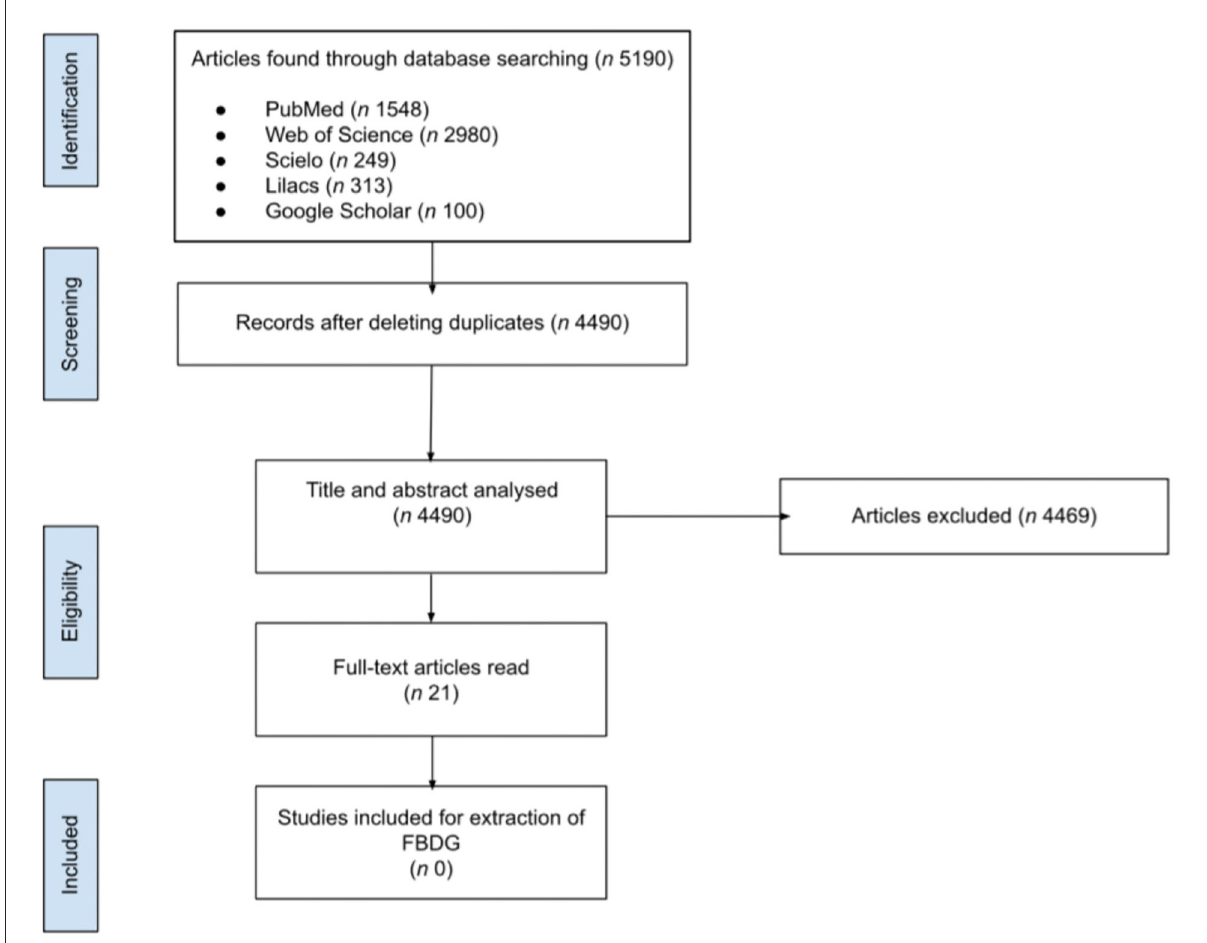
FIGURE2 Flow diagram representing the selection process of articles for part 2 (systematic review) of the present